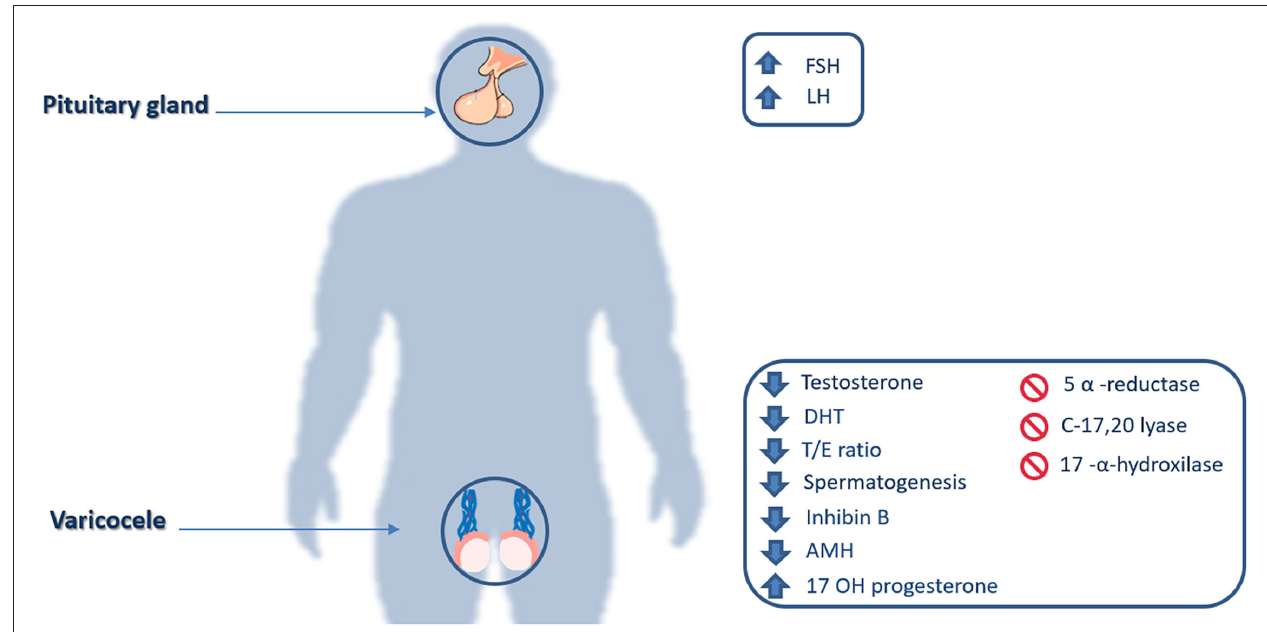
FIGURE 2 | Hormonal and enzymatic impairments. FSH, Follicle-stimulating hormone; LH, Luteinizing hormone; DHT, Dihydrotestosterone; T/E ratio, Testosterone/estradiol ratio; AMH, Anti-Müllerian hormone; 17 OH Progesterone, 17 α -Hydroxyprogesterone.